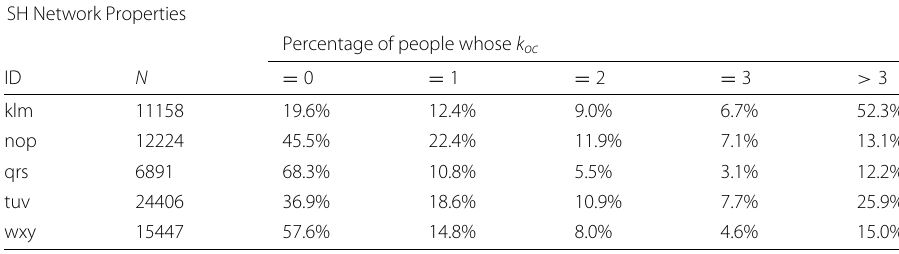
Table 2 Statistics of networks composed of three SH clusters from Table 1 SH Network